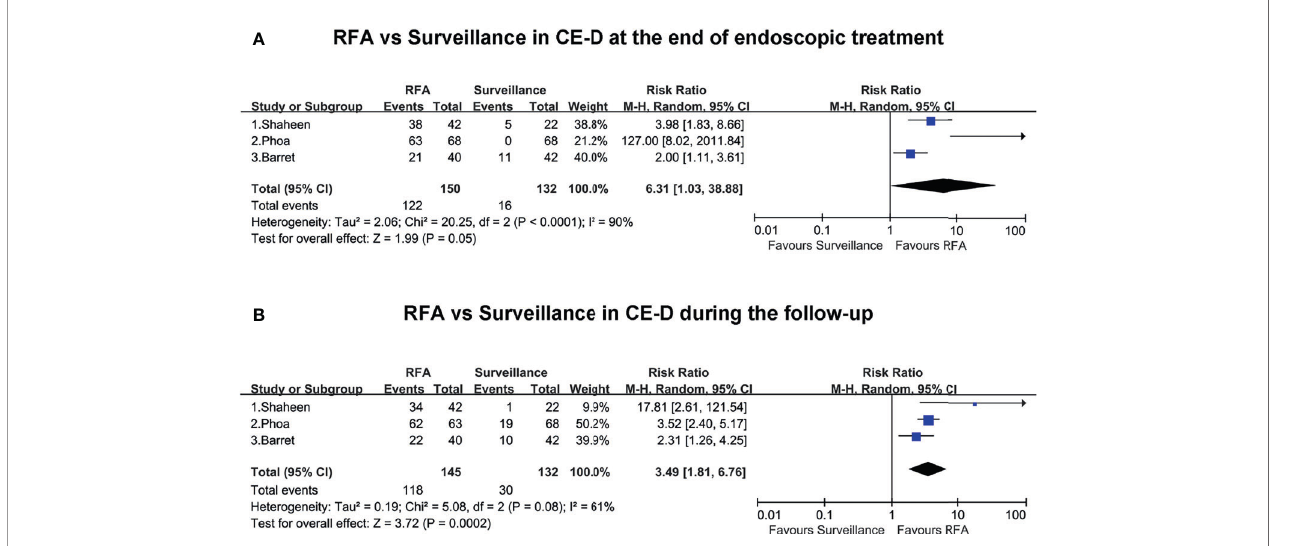
FIGURE 3 | (A) RFA vs. surveillance for CE-D at the end of endoscopic treatment. (B) RFA vs. surveillance for CE-D during the follow-up.